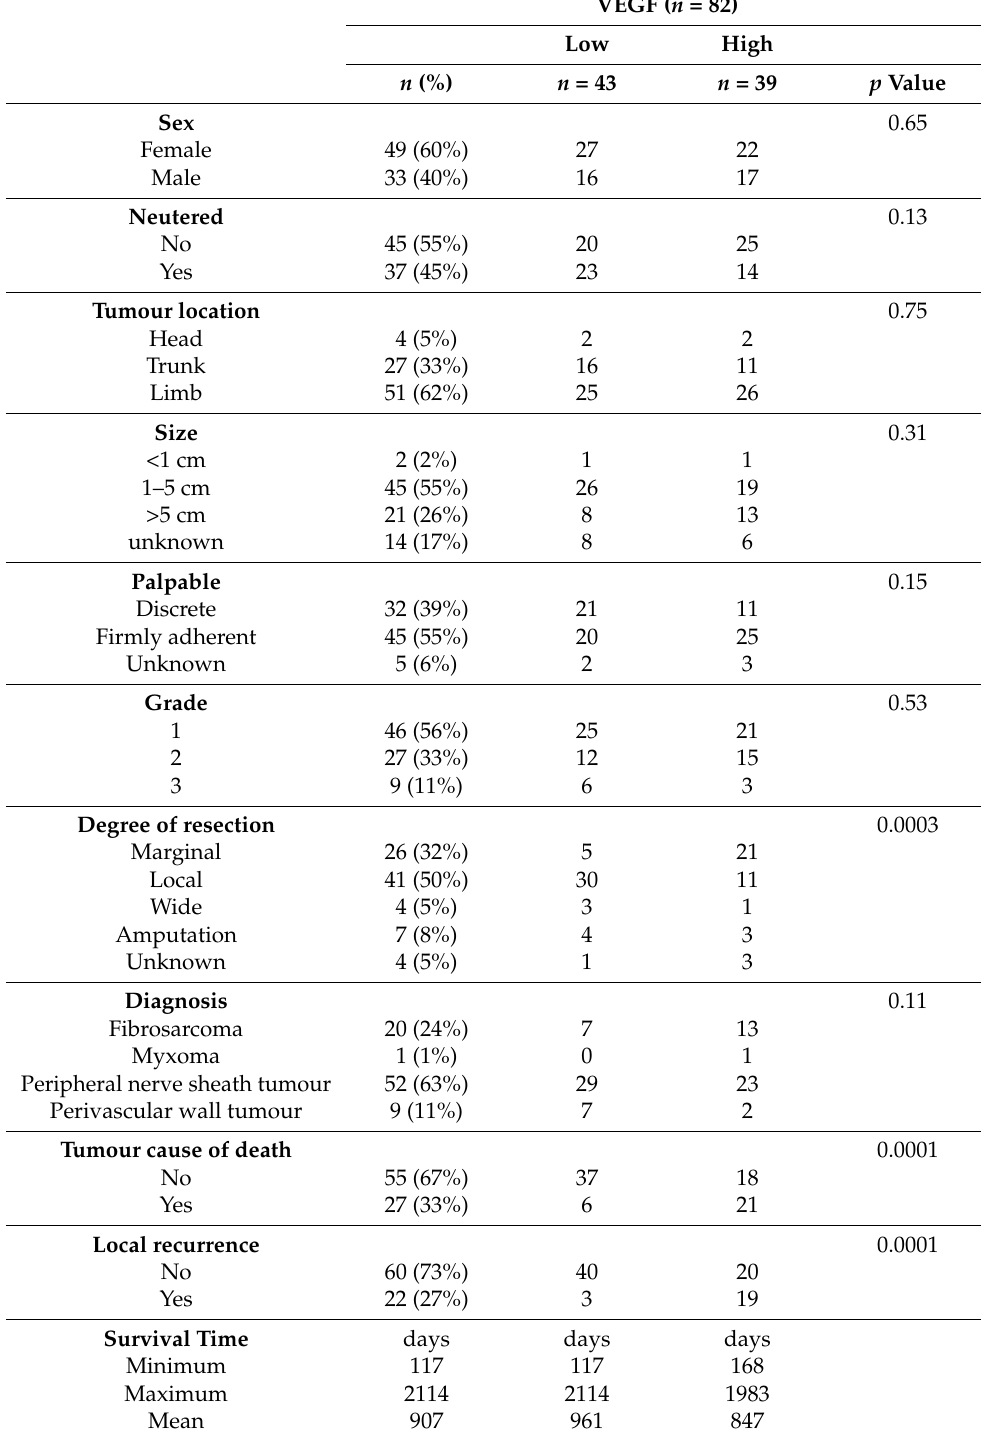
Table 2. Results from chi-square analysis for different tumour characteristics and VEGF